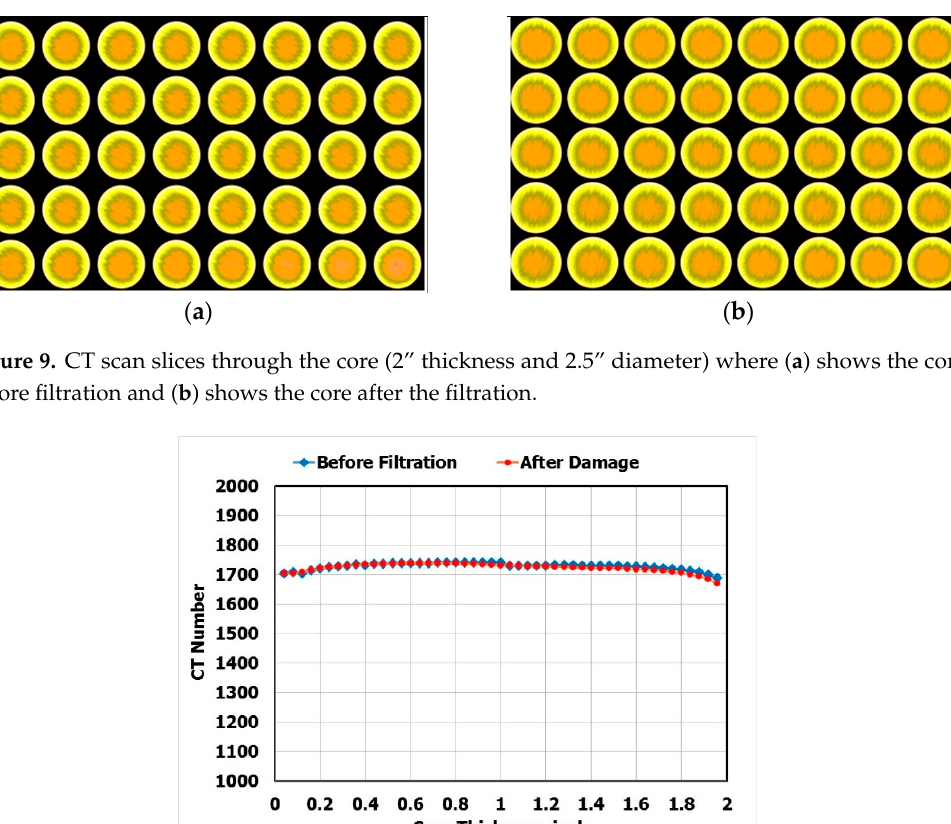
Figure 10. Computer tomography scan before filtration and after damaging the tight sunstone core with the drilling fluid.